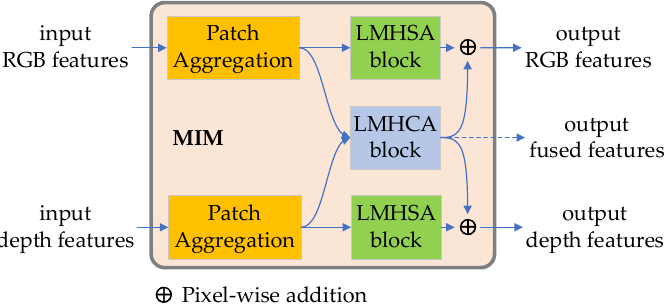
Figure 3. The structure of the MIM module.